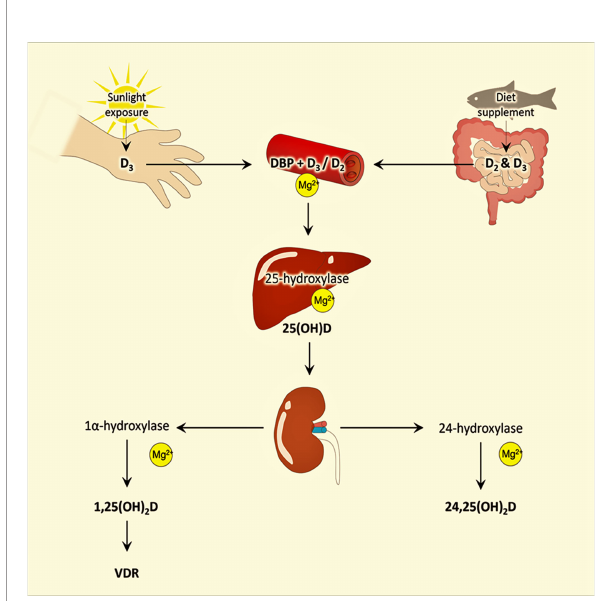
FIGURE 2 | Simpli fi ed diagram of the different stages of vitamin D synthesis and role of magnesium in the activation of vitamin D; modi fi ed from earlier publications. For simplicity, only the essential steps of vitamin synthesis are included. VDR, vitamin D receptor; DBP, vitamin D binding